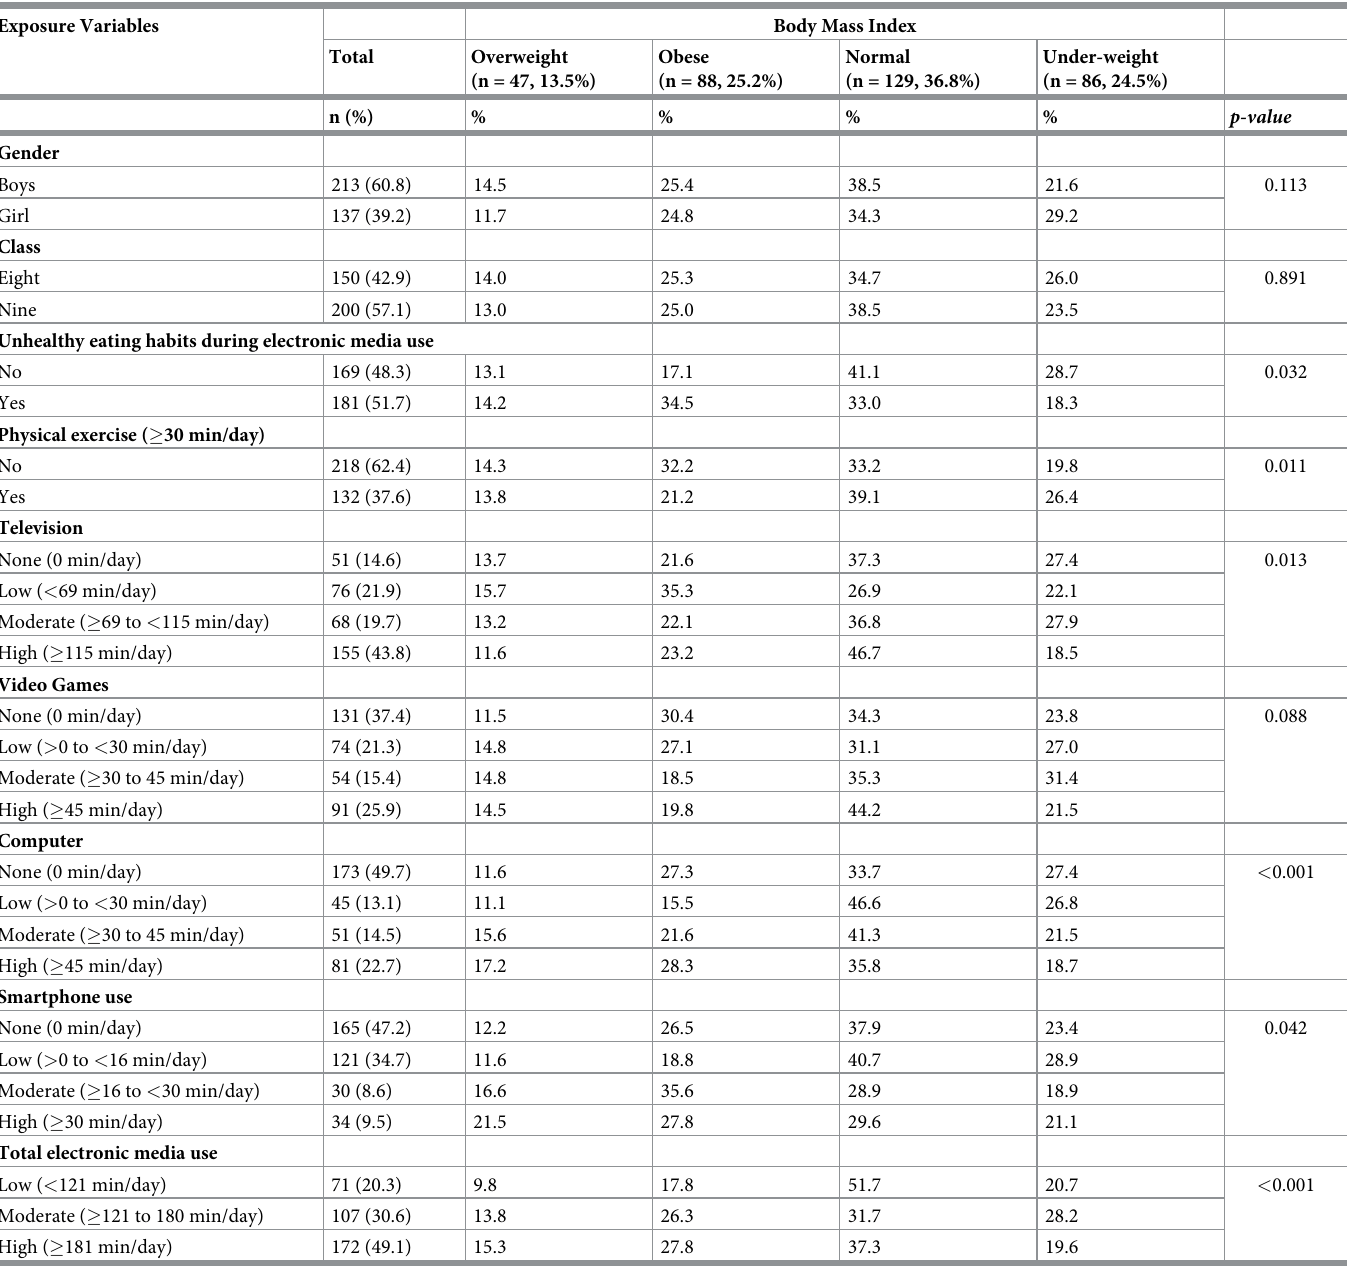
Table 2. Bivariate analysis of exposure variable with BMI in Bangladeshi adolescents. Exposure